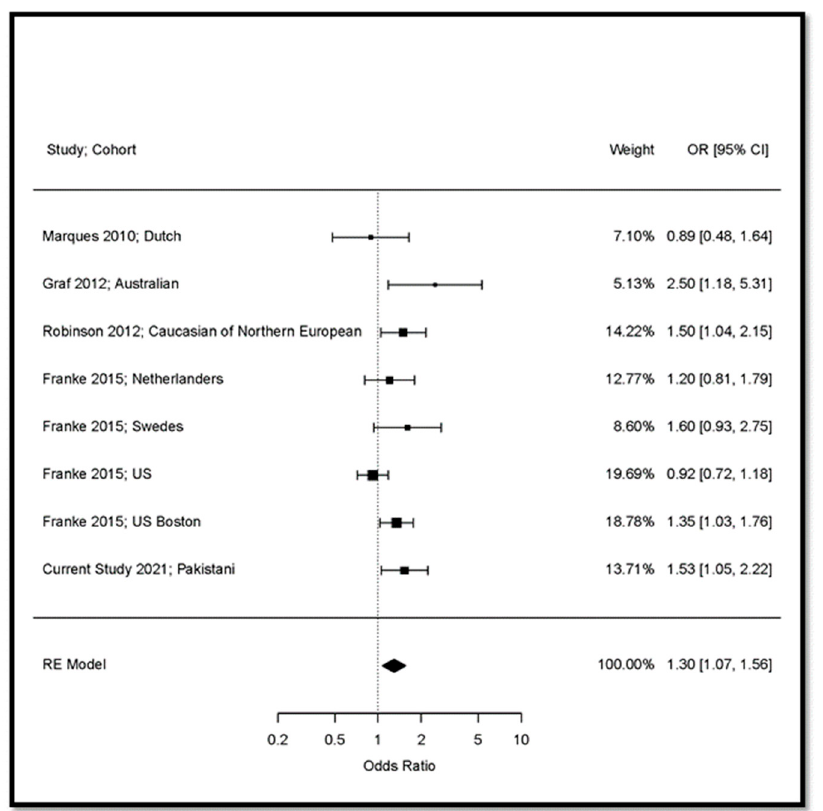
Figure 2. Random effects meta-analysis of the association of FCGR3B CNV (<2 versus 2 copy numbers) with RA. US: United States of America; UK: United Kingdom; OR: Odds Ratio; RE: Random Effects; CI: Confidence Interval.